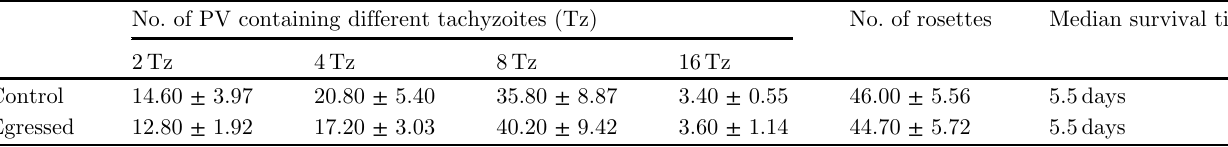
Table 1. Egressed parasites displayed normal growth, infectivity and virulence. HFFs were infected with egressed tachyzoites (TNF- a -induced egress) or naturally egressed T. gondii . Twenty-four hours later, ten fi elds were randomly selected and the number of PV containing different tachyzoites was counted using an Olympus IX51 microscope. This experiment was repeated three times with similar results. C57BL/6 mice were infected intra-peritoneally with 10 3 tachyzoites and the survival rate was evaluated every day. Bars represent means ± SDs of fi ve replicates. This experiment was repeated three times with similar results. No. of PV containing different tachyzoites